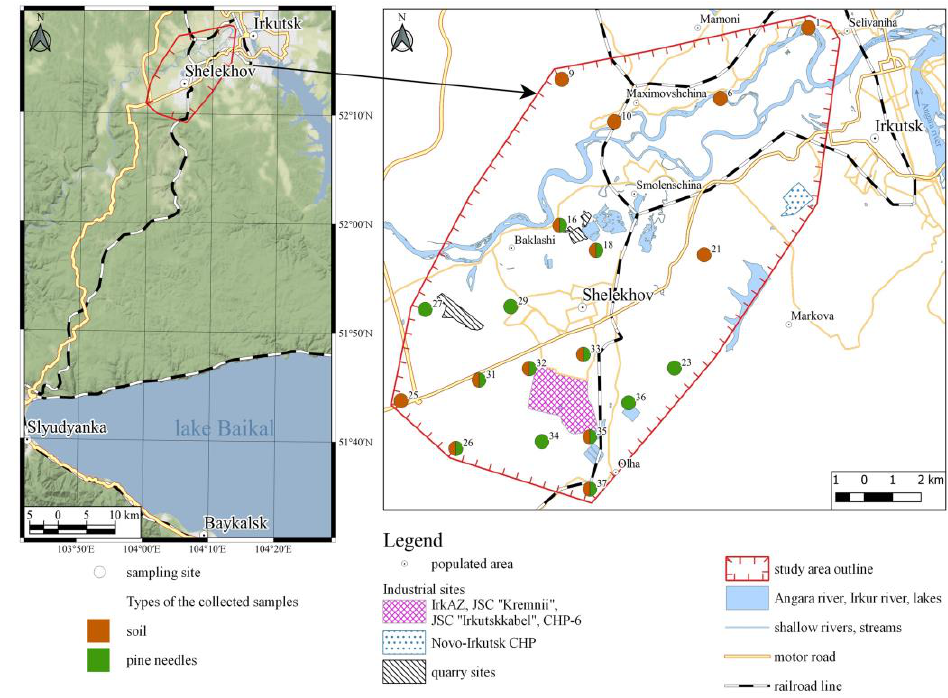
Figure 1. Map and scheme of the studied area.